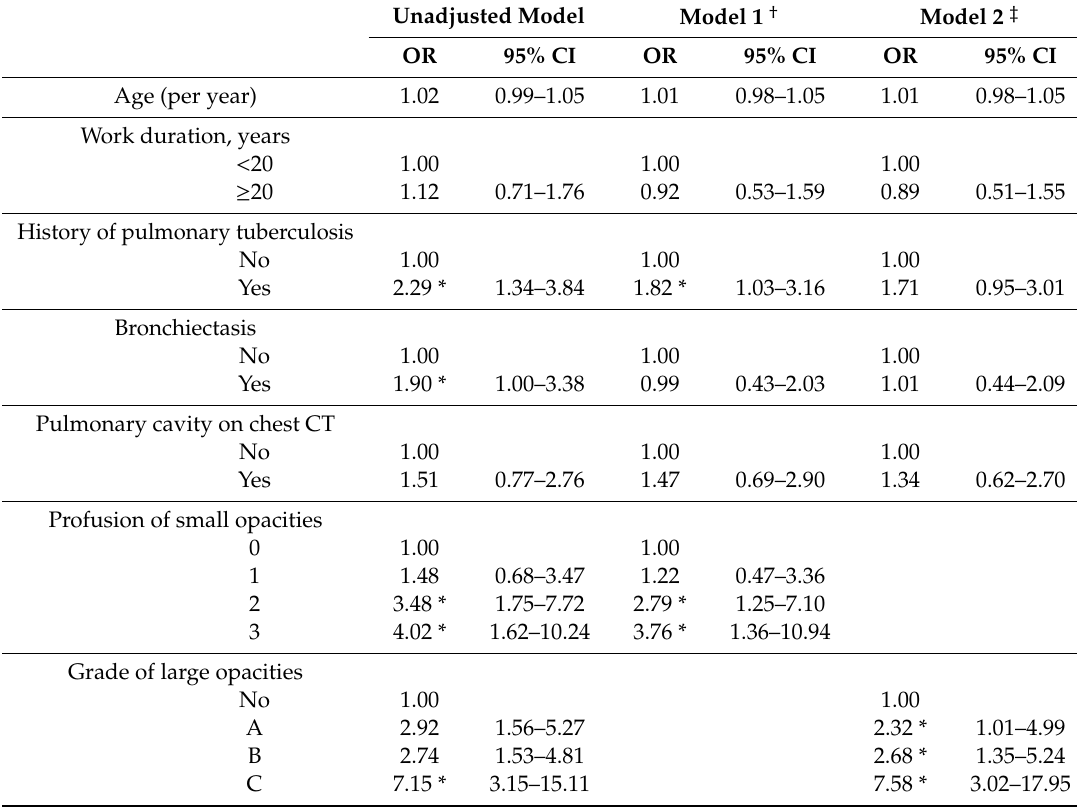
Table 3. Multiple logistic regression analysis of the relationship between nontuberculous mycobacteria infection and occupational, clinical, and radiological